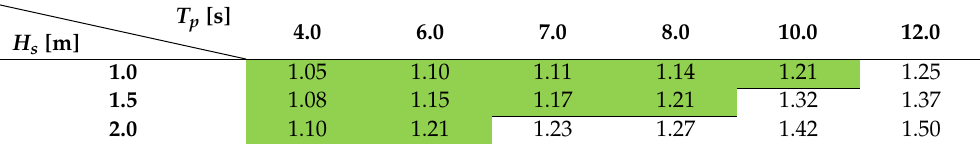
Table 10. DAF of different sea states. (Allowable sea states are marked in light green background).